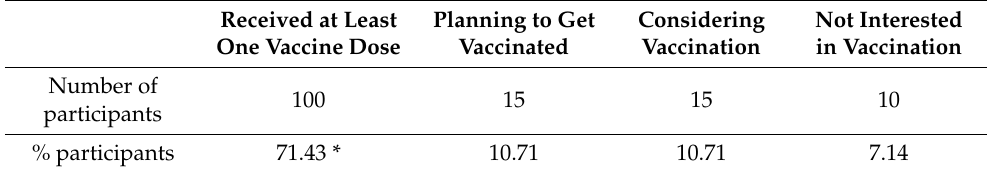
Table 3. Participants’ vaccination status in August 2021.